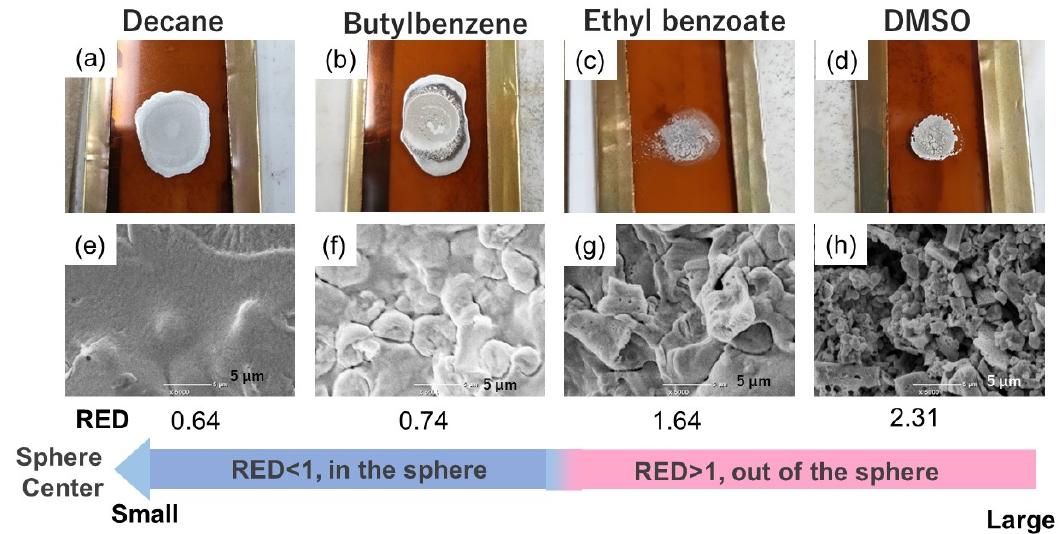
Figure 5. Sintered Ag films at 200 °C using OAm-Ag NP inks with ( a ) decane; ( b ) butylbenzene; ( c ) ethyl benzoate; and ( d ) DMSO. SEM images of sintered Ag films at 200 °C from OAm-Ag NP inks with ( e ) decane; ( f ) butylbenzene; ( g ) ethyl benzoate; and ( h ) DMSO.